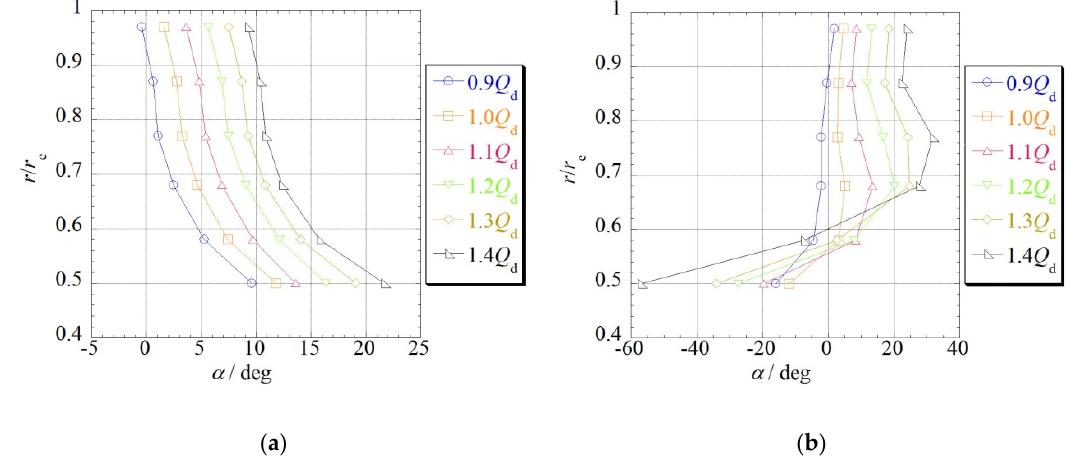
Figure 9. The attack angle of original model: ( a ) Upstream the front rotor; ( b ) Upstream the rear